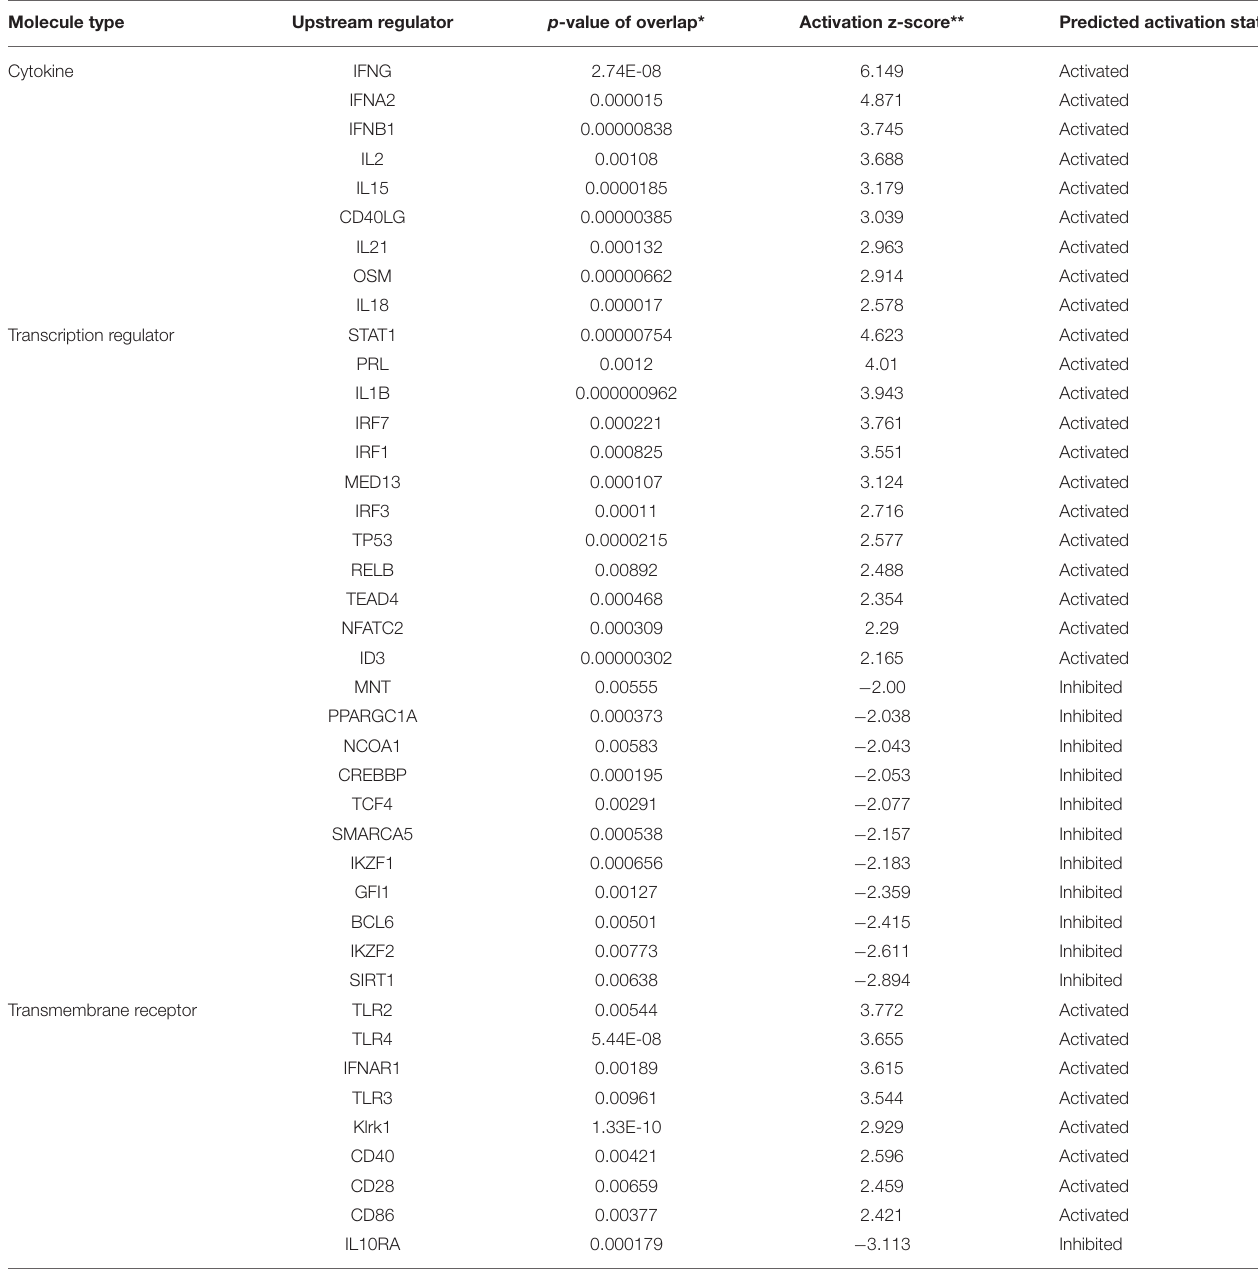
TABLE 1 | Upstream analysis of LDR-SC2 unique